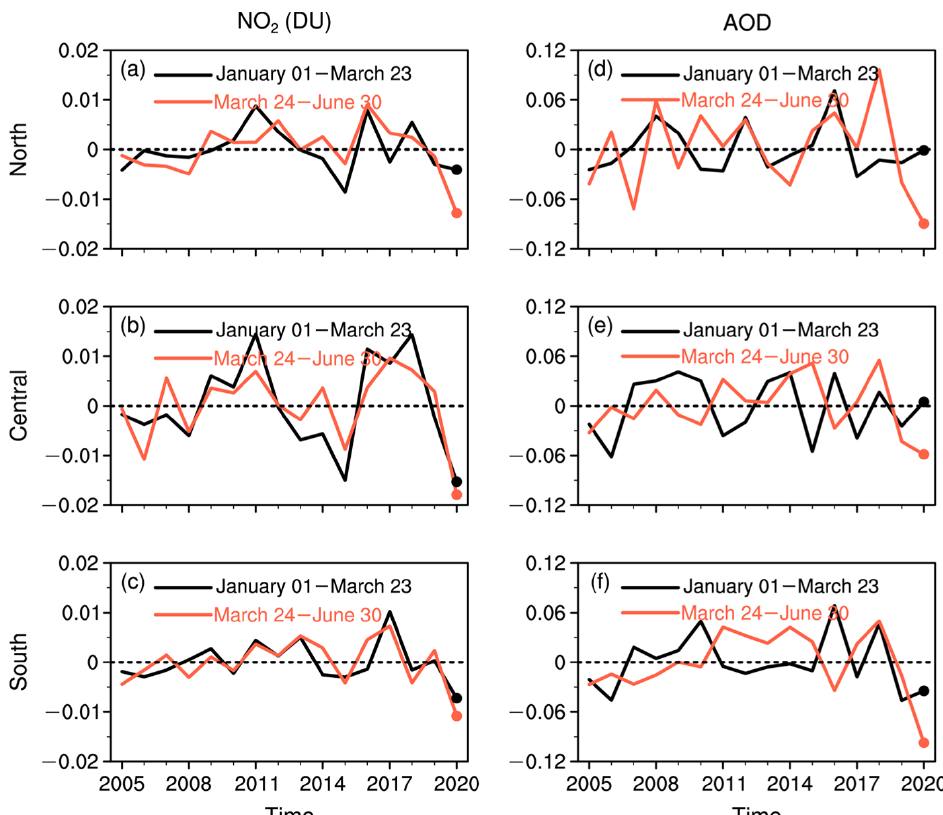
Figure 2. Annual time series of de-trended tropospheric NO 2 and AOD from 2005 to 2020 over three subregions in the Indian subcontinent (Figure 1). ( a – c ): tropospheric NO 2 and ( d – f ): AOD. The black and light-red lines respectively represent the period of 1 January–23 March and 24 March–30 June. The black and light-red dots respectively represent the mean values of tropospheric NO 2 and AOD during the period of 1 January–23 March and 24 March–30 June in 2020, respectively.